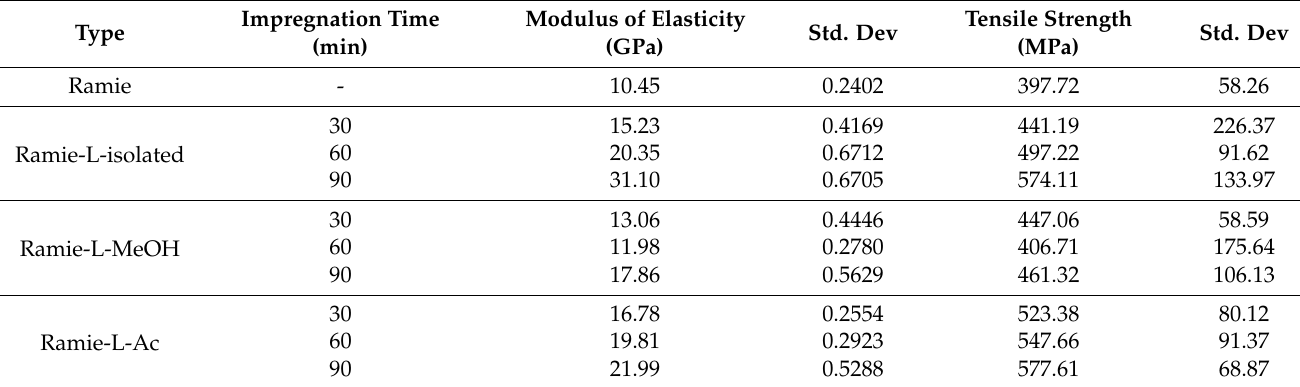
Table 6. Modulus of elasticity (MOE) and tensile strength of ramie and impregnated ramie fibers at different impregnation